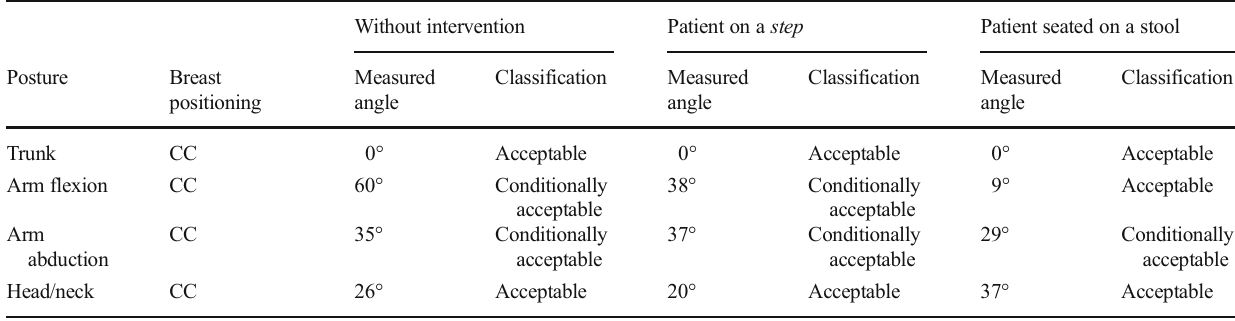
Angles measured on radiographer during MLO breast positioning (radiographer and patient with identical the stature) Without intervention Patient on a step Radiographer seated on Posture Breast